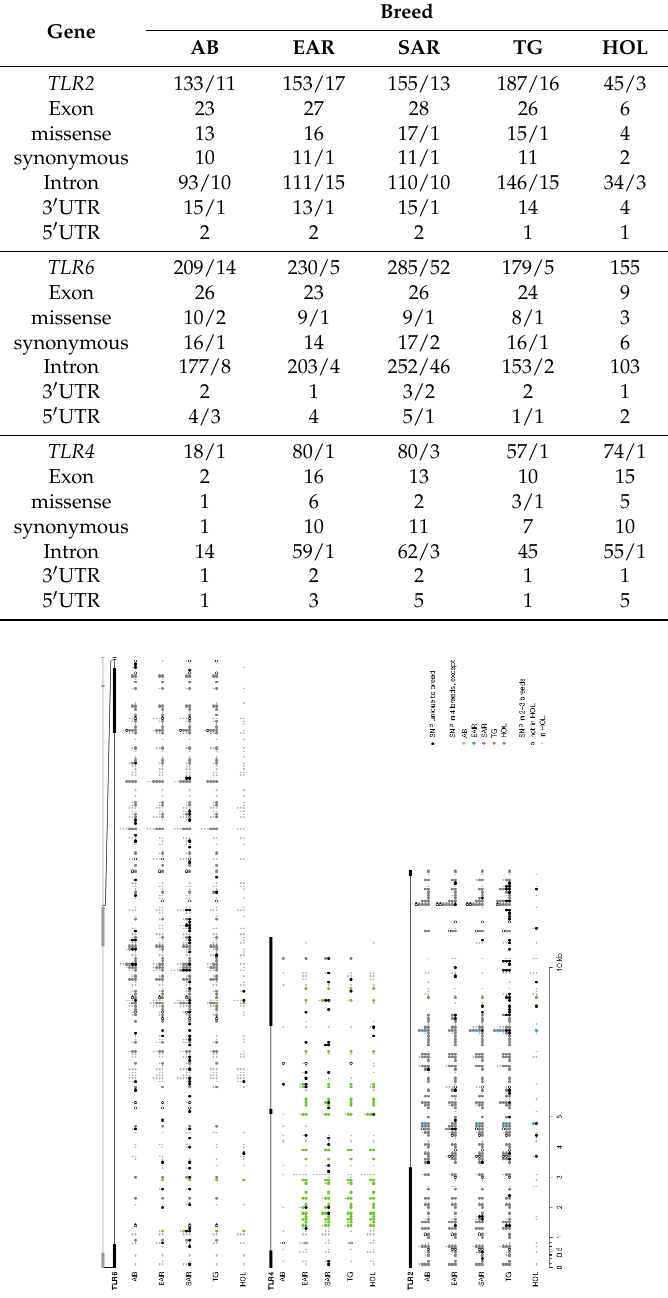
Table 1. SNP variants identified in TLR2 , TLR4 , and TLR6 genes. In each cell of the table, the total/novel number of SNPs is shown, or only the total if no novel SNPs were found.